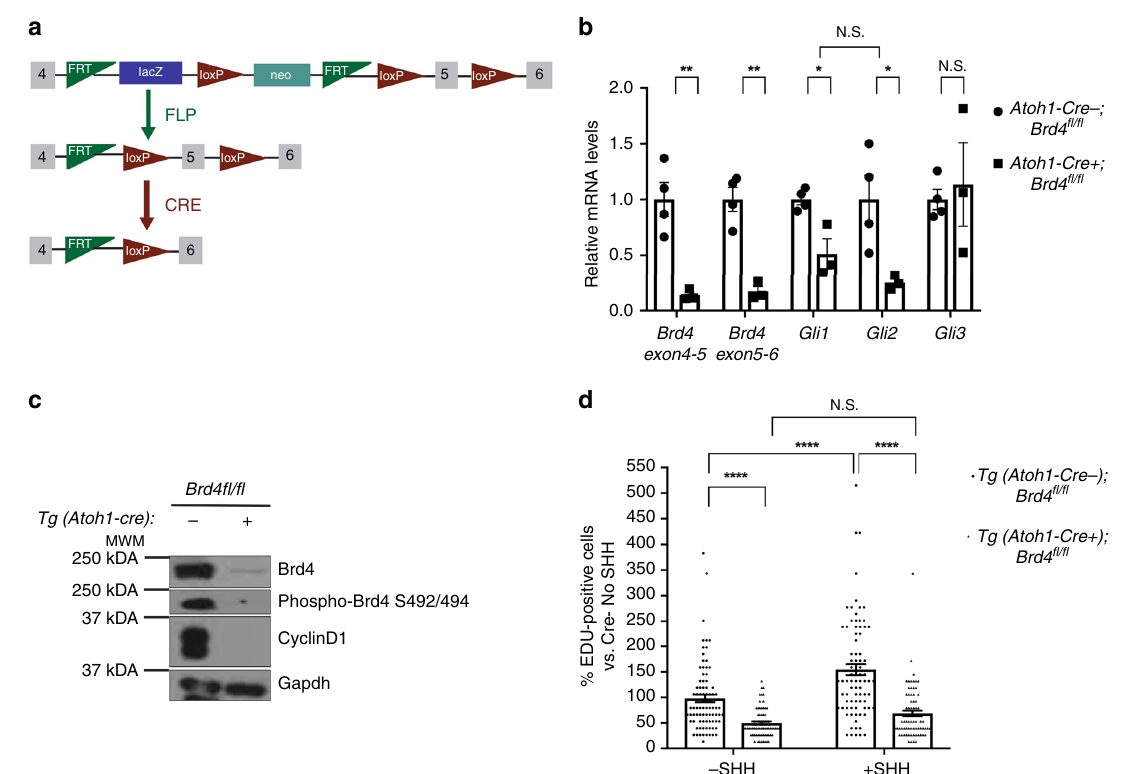
Fig. 5 Conditional deletion of Brd4 in GCPs inhibits the sonic hedgehog pathway and SHH mediated proliferation. a Strategy utilized for deleting Brd4 conditionally in the cerebellum. Brd4 tm1a(EUCOMM)Wtsi heterozygous mice were obtained through the Knockout Mouse Project Repository at